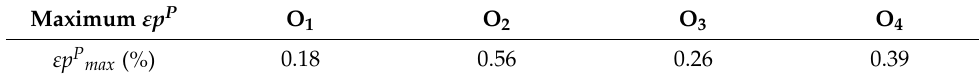
Table 4. Maximum remaining error after calibration using five error